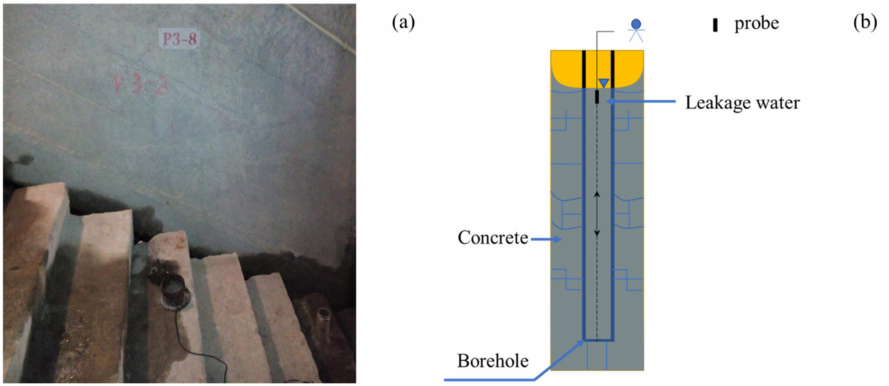
Figure 4. Illustration of well-logging with natural tracer: ( a ) on-site photo; ( b ) sketch of the logging